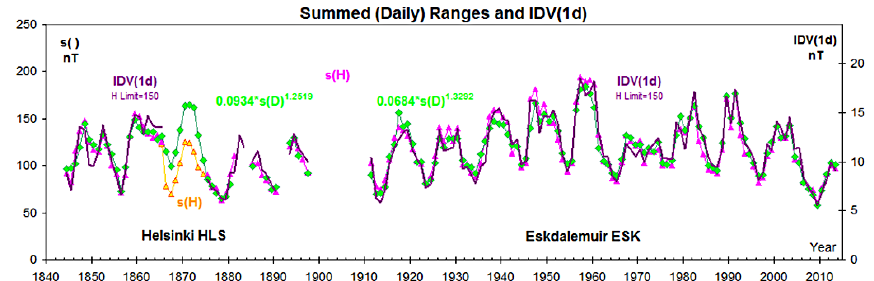
Figure 3. Yearly average summed ranges for H (pink triangles) and for D (green diamonds) scaled to match the scale of H using the equations in green for HLS (left) and ESK (right). The equations are slightly different because the inhomogeneous “raw” values are plotted, i.e., not normalized to a common “bridge”. The values of s(H) for the interval 1866–1874.5 (orange symbols) do not match the rest of the s(H) to scaled s(D) . IDV(1d) calculated from H for ESK (purple symbols; scale on right) is a good fit to s(H) and s(D) . A few “spikes” have been suppressed by capping daily IDV(1d) at 150nT. IDV(1d) calculated from H for HLS (scale at right; same scale as for ESK as no normalization between HLS and ESK is performed – this is raw data – for this inhomogeneous data set) is also a good fit to s(H) and s(D) , except for the interval 1866–1874.5.